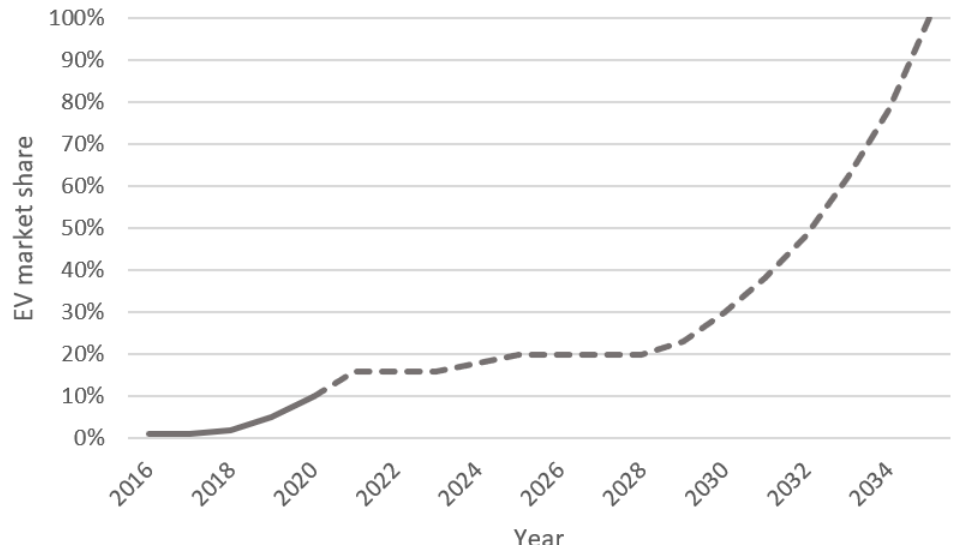
Figure 1. EU-expected evolution of EV sales under current regulations. (Data collected from [18] on 26 May 2021).